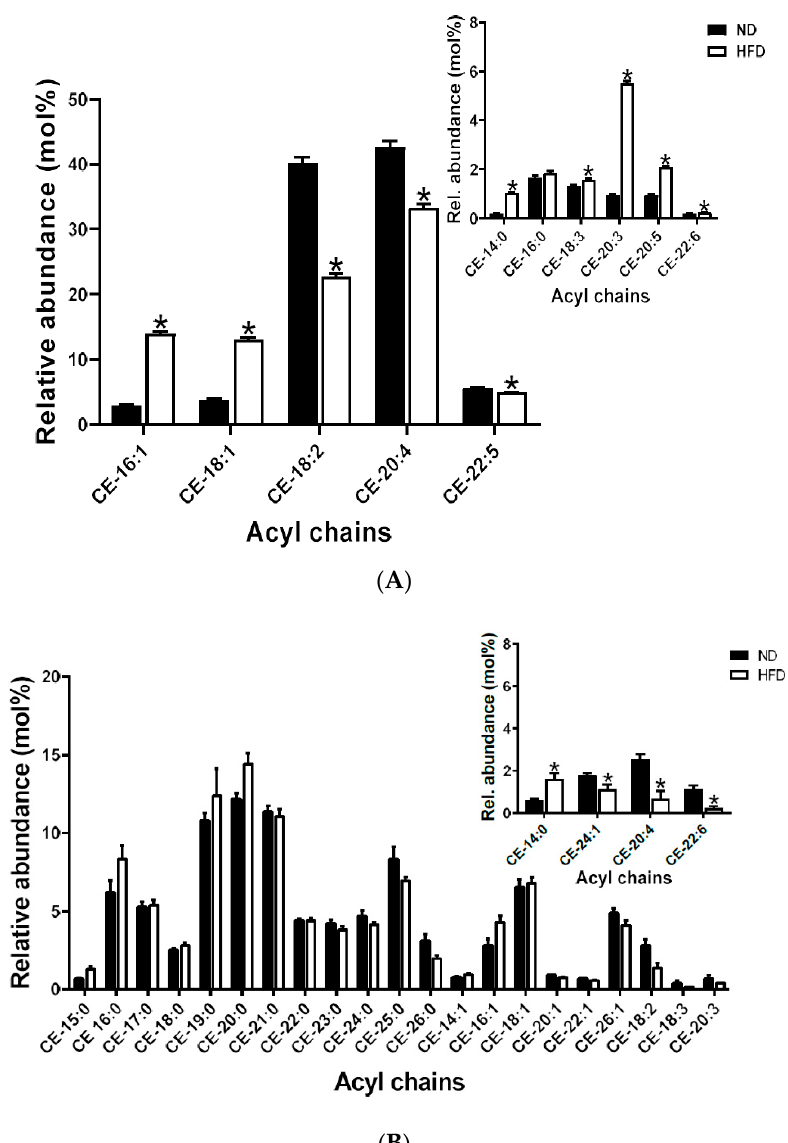
Figure 4. ( A ) Plasma cholesteryl ester species detected; inset shows species with low relative abundance. Data are expressed as means ± SEM, * p < 0.05. Asterisks indicate a significant difference compared to the matched ND value. ( B ) Meibum cholesteryl ester species detected; inset shows species with low relative abundance. Data are expressed as means ± SEM, * p < 0.05. Asterisks indicate a significant difference compared to the matched ND value.